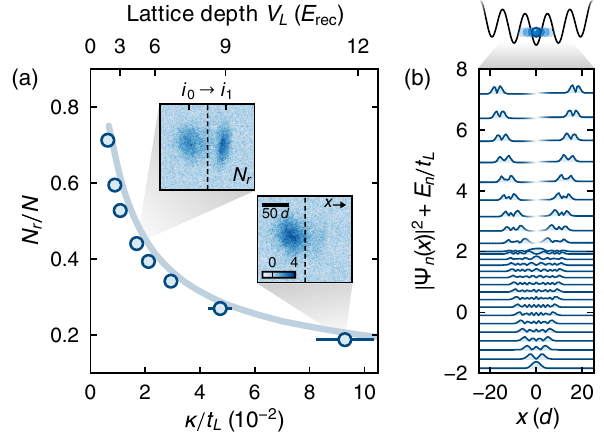
FIG. 2. Wannier-Stark localization in the absence of inter- =N transported to the right actions. (a) Fraction of light atoms N r half of the system (blue circles) in the absence of heavy atoms and for variable confinement κ =t determined by the lattice depth V . L L Each point is the average of 2 – 5 measurements, and error bars indicate the uncertainty of κ =t (partly smaller than the marker L size). The solid line corresponds to our numerical calculation [42], and the insets show raw atomic column densities for κ =t L ¼ 1 . 7 ð 1 Þ × 10 − 2 and 9 ð 1 Þ × 10 − 2 with the dashed lines indicating the boundary that determines the atom count N in the right half of r x Þj 2 and eigenenergy the system. (b) Probability density j Ψ n ð E =t of the lowest-lying single-particle eigenstates for V n L L ¼ 4 . 9 × 10 − 2 ). We add a small linear potential to lift 9 E ( κ =t L ¼ rec the degeneracy of the localized